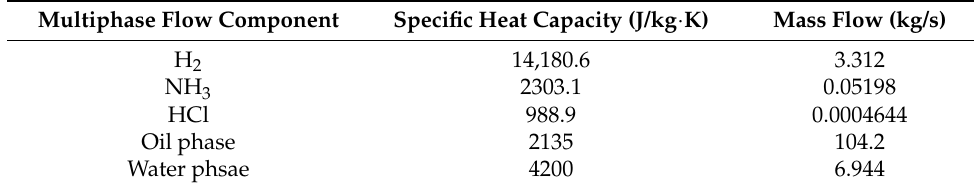
Table 4. Gas phase component content at inlet.